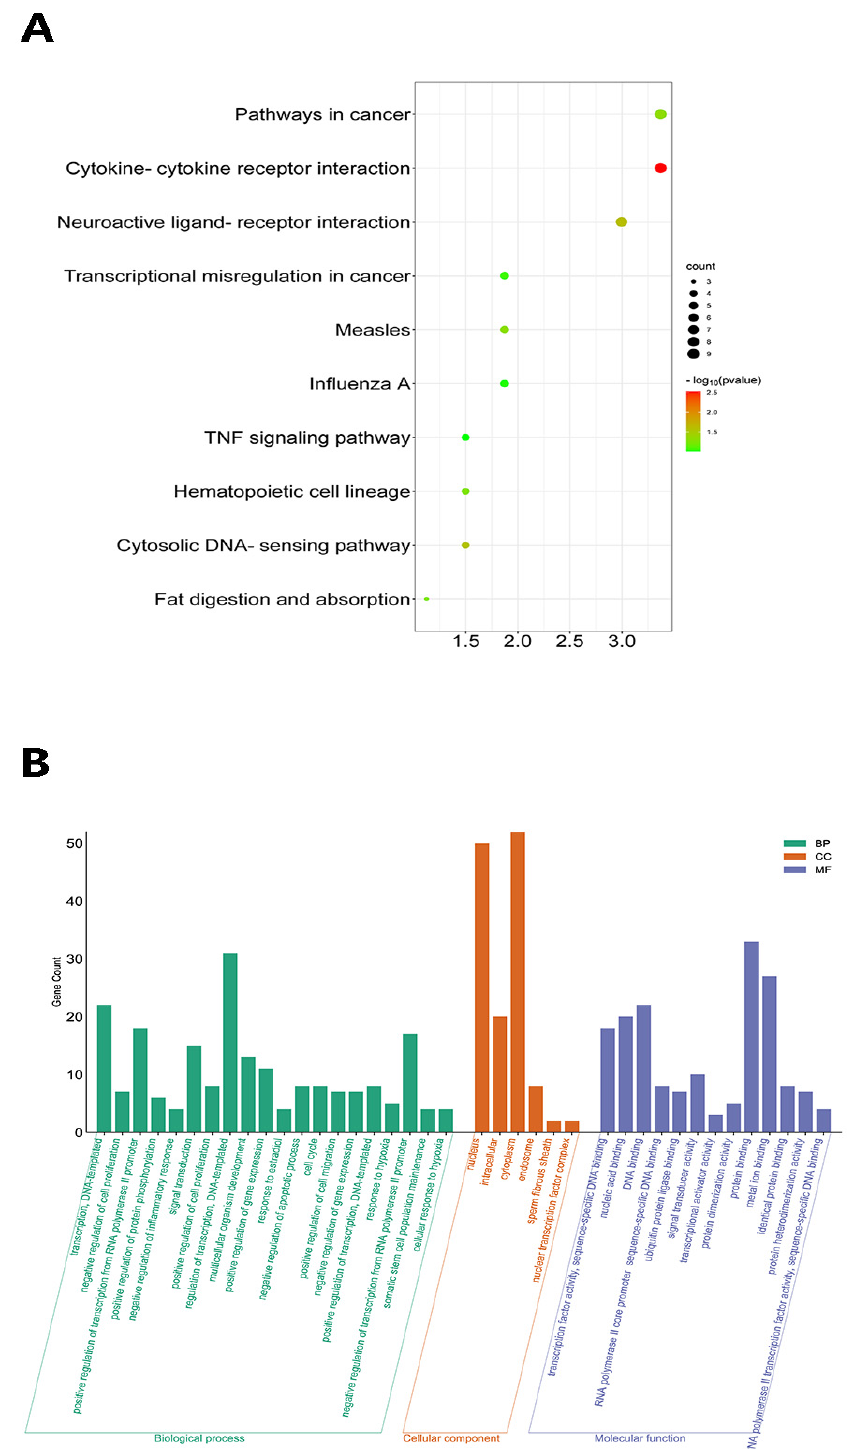
Figure 6. Visualization of GO and KEGG pathway enrichment analysis. ( A ): KEGG enrichment bubble plot. The color of the bubble indicates the p -value and the size indicates the number of genes. ( B ): GO enrichment significant bar chart. The names of gene ontology are seen in the horizontal axis and gene count in the vertical axis. The result of GO functional enrichment analysis is composed of 3 parts: cellular component (green bar), biological process (yellow bar) and molecular function (blue bar).